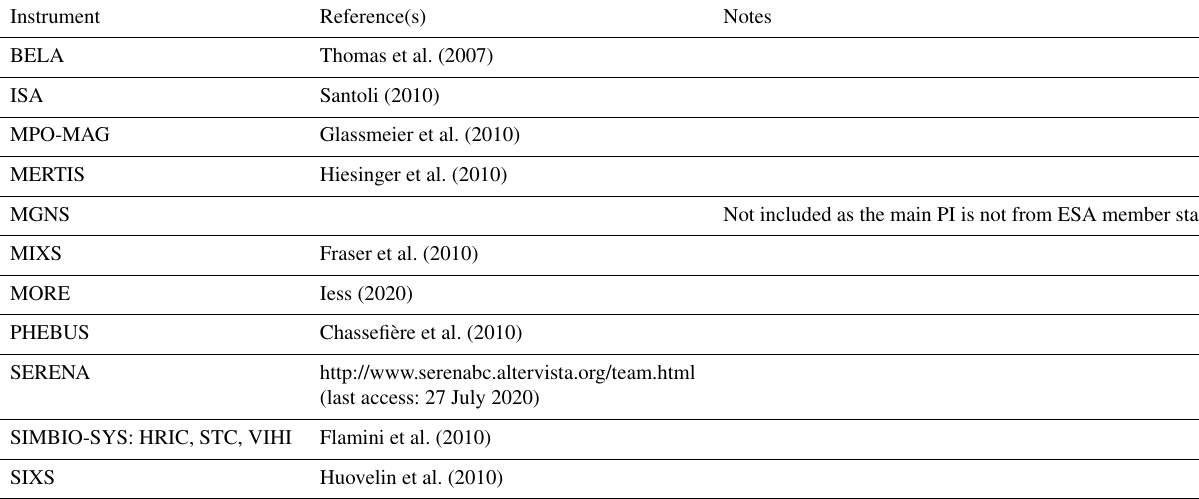
Table A7. Bepi Colombo’s instruments and references for team members lists.